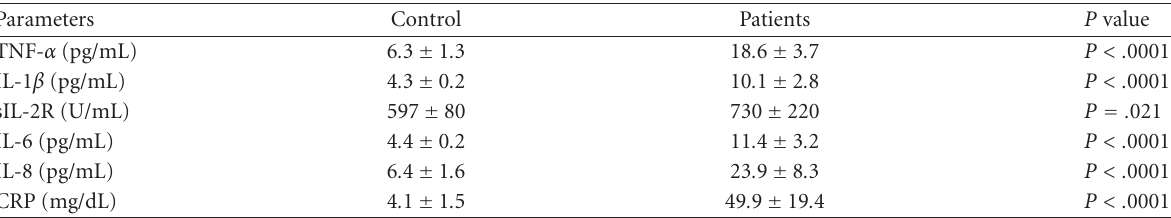
Table 1. Comparison of serum levels of cytokines and CRP (mean ± SD) in patients with MM. Parameters